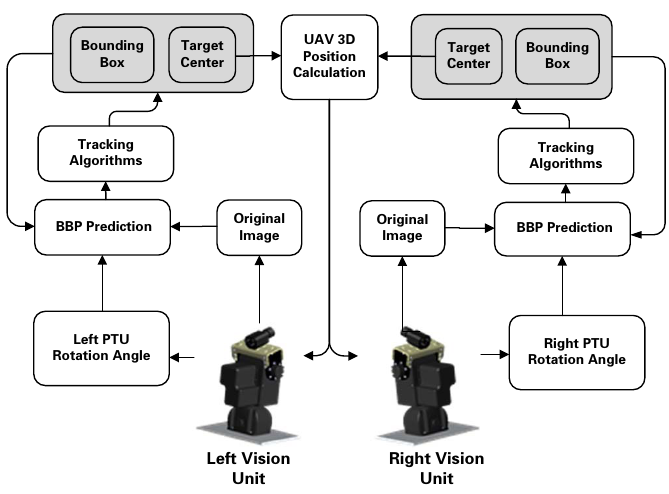
Figure 11. PTU-based UAV localization framework.